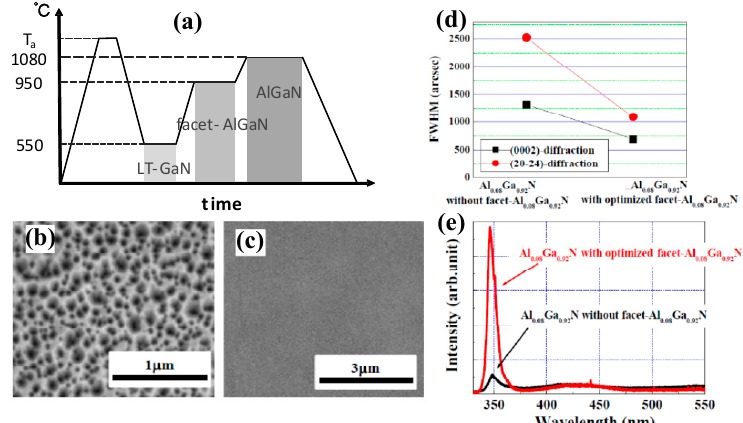
Figure 12. ( a ) Timing charts of growth temperatures of GaN using facet layers. Plan-view SEM images of ( b ) facet-Al 0.08 Ga 0.92 N and ( c ) Al 0.08 Ga 0.92 N grown on facet-Al 0.08 Ga 0.92 N layer at 1080 °C. ( d ) XRC FWHM and ( e ) PL spectra of Al 0.08 Ga 0.92 N without and with facet-Al 0.08 Ga 0.92 N layer. Reprinted with permission from Reference [111]. Copyright 2012 Wiley.